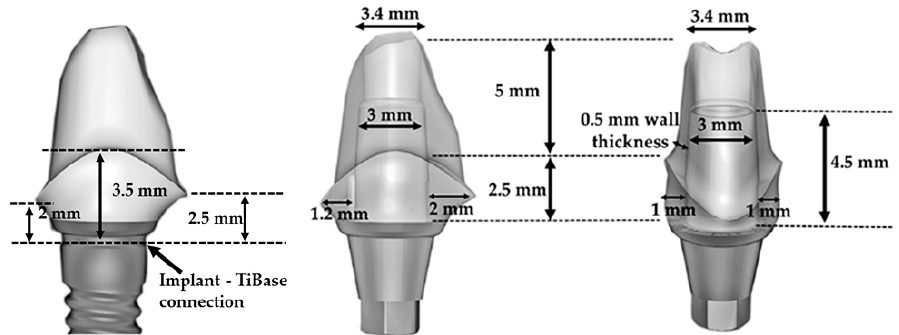
Figure 2. Interproximal (left and middle) and palatinal (right) views of designed custom abutment in CAD software. Dimensions of titanium insert base and ceramic coping are presented.